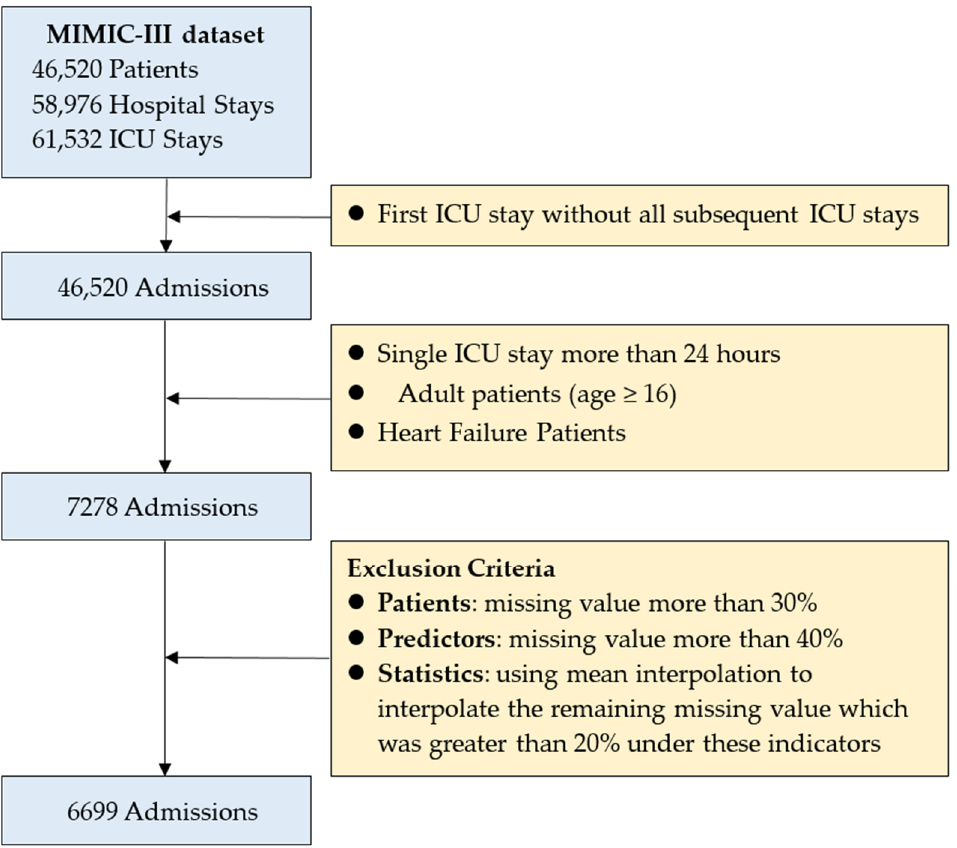
Figure 1. The detailed process of data extraction.